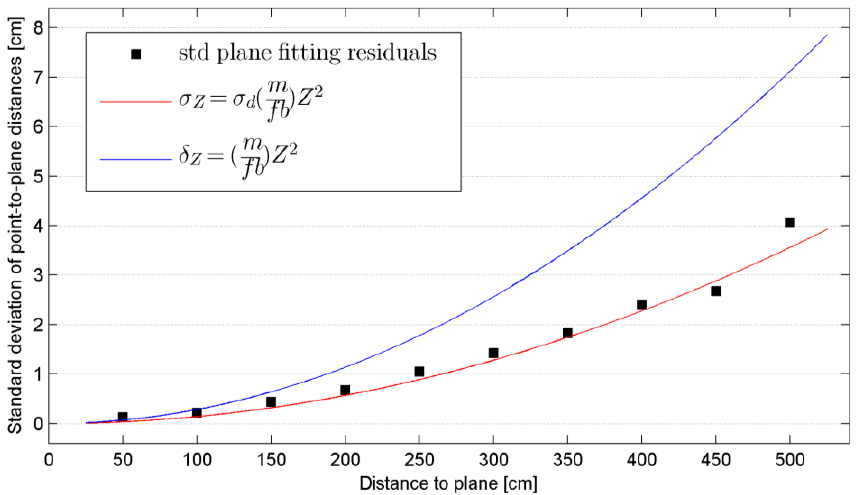
Figure 10. Standard deviation of plane fitting residuals at different distances of the plane to the sensor. The curves show the theoretical random error ( red ) and depth resolution ( blue